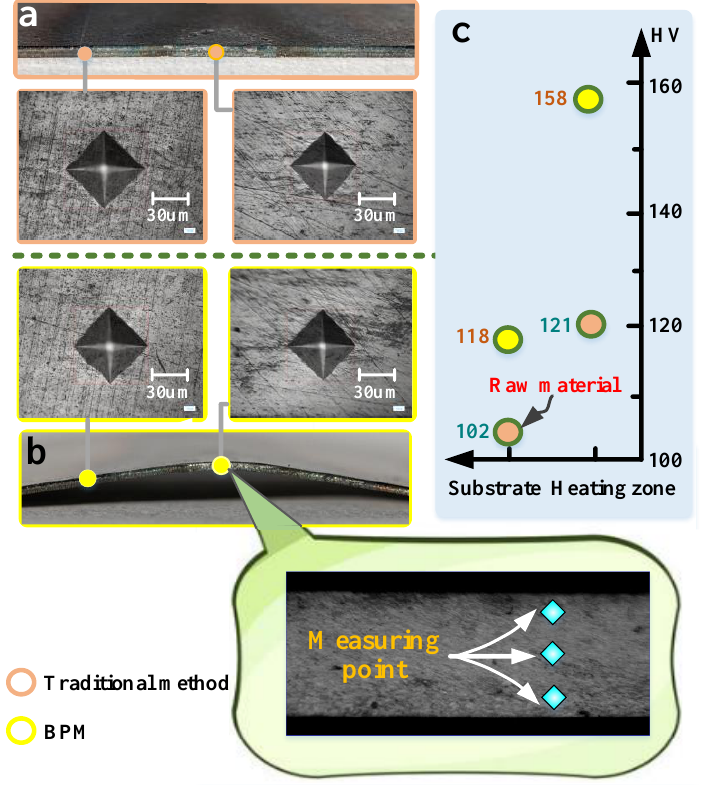
Figure 14. Comparison of microhardness values between the two methods: ( a ) traditional method, ( b ) BPM and ( c ) values of microhardness.